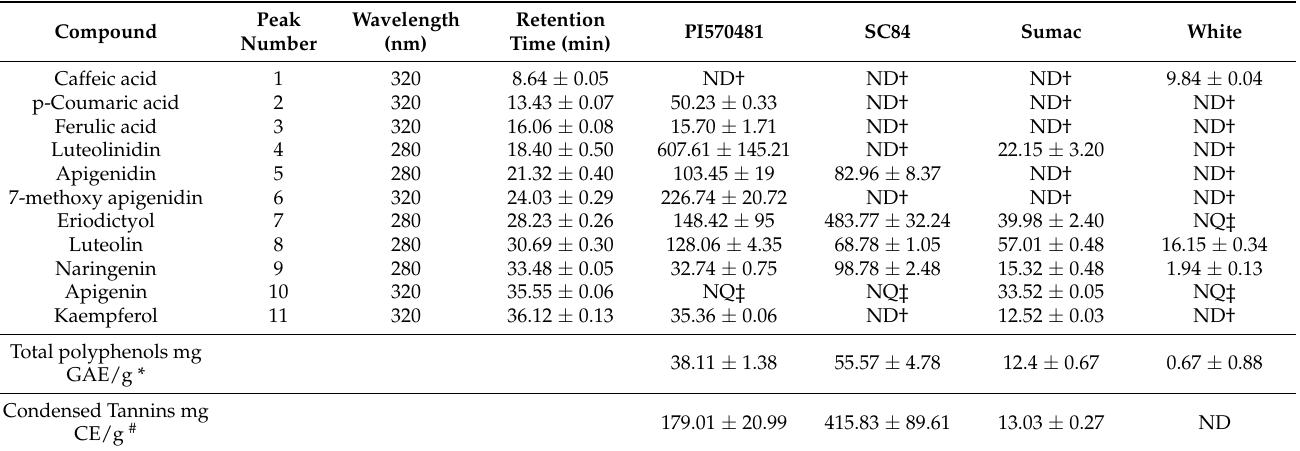
Table 1. Identified polyphenol compounds, total phenolics, and condensed tannins in four sorghum genotypes.